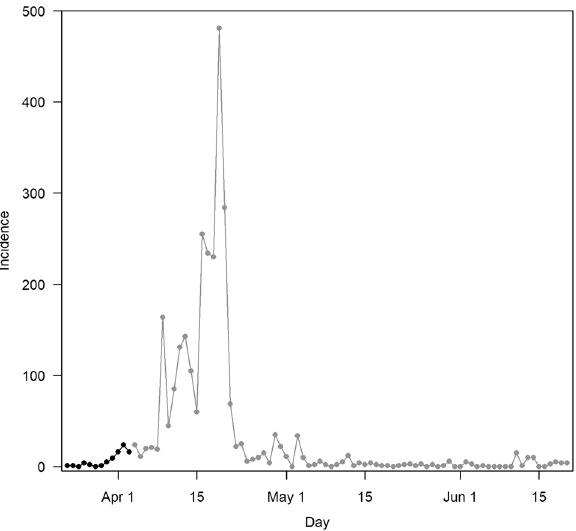
Figure 1. Outbreak trajectory in the dormitory. Observed symptomatic cases with onset on or before Apr 3, 2020(black dots, up to day 12 of the outbreak) were used for model fitting. Cases after Apr 3, 2020 (grey dots) were plotted based on notification dates if onset dates were not available and were not used for model